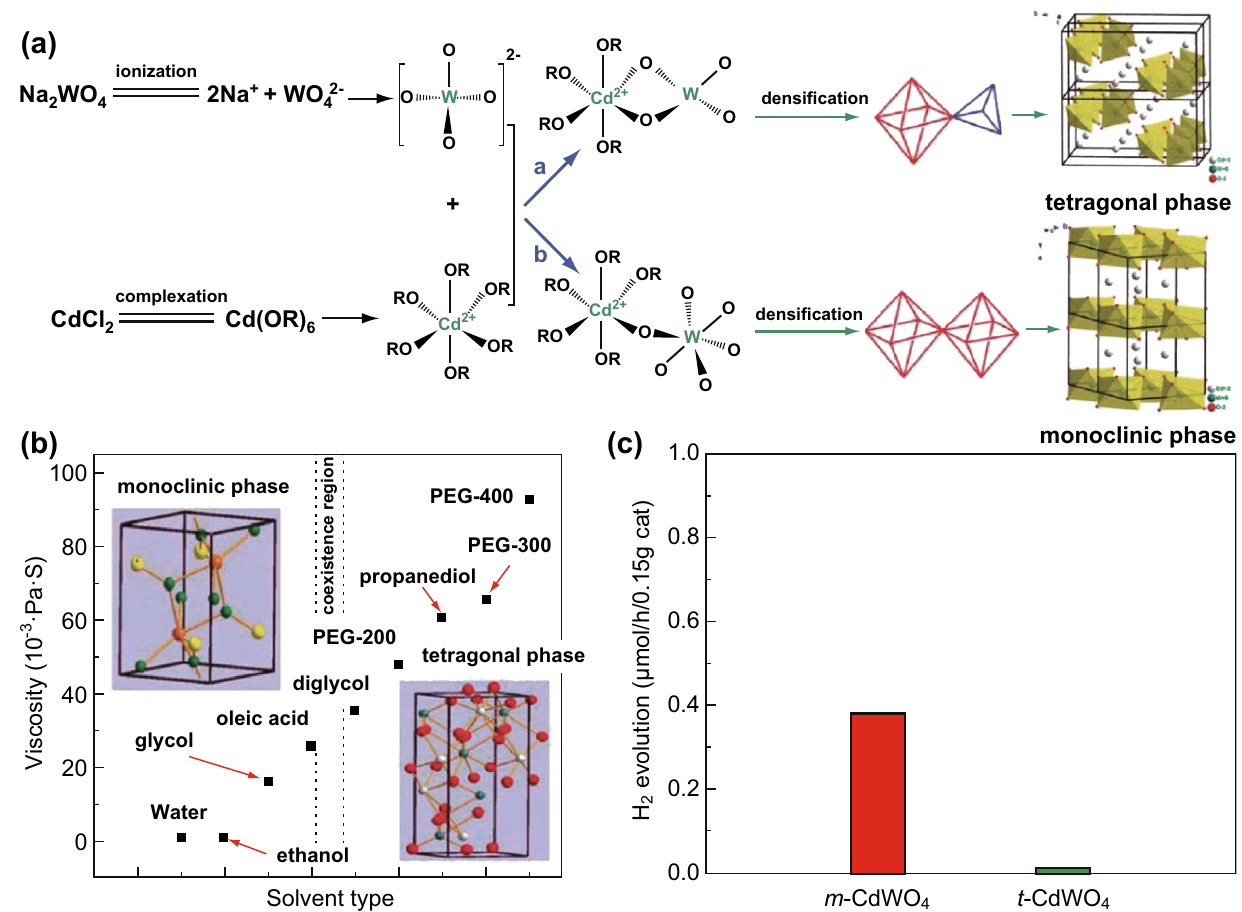
Fig. 8 a Formation mechanism of m-CdWO 4 and t-CdWO 4 and the b relationship between different crystal phases of CdWO 4 and used solvents. c Photocatalytic H 2 evolution of m-CdWO 4 and t-CdWO 4 under visible light irradiation. Reproduced with permission from Ref. [86]. Copyright 2012 Royal Society of